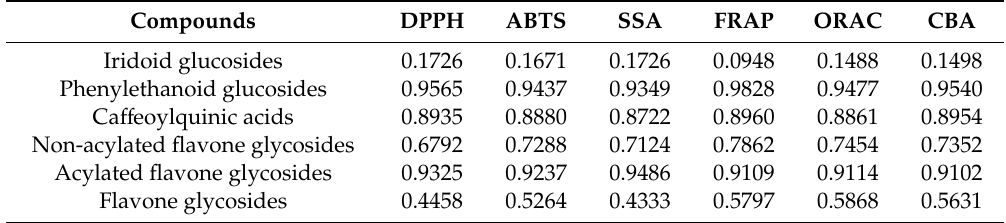
Table 6. Regression coe ffi cients ( r 2 ) of “antioxidant activity–compound content” relationships. Compounds